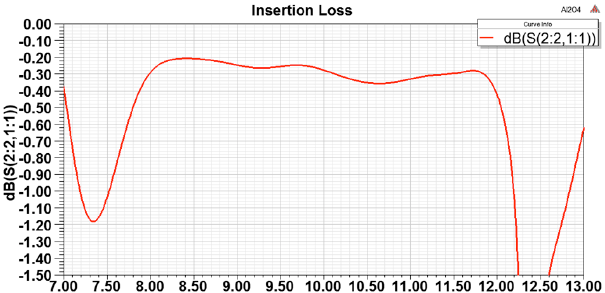
Figure 5: TE to TE transformation loss. It is the 10 20 S when at the port 1 there is the first mode and at 21 the port 2 the second mode is wanted.